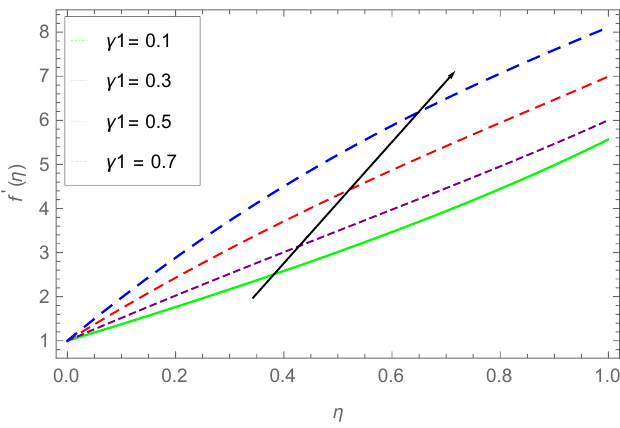
Figure 5. Impact of γ 1 on f (cid:48) ( η ) , when Gm = 0.8, β = 0.9, St = 0.3, Gr = 0.7, M =